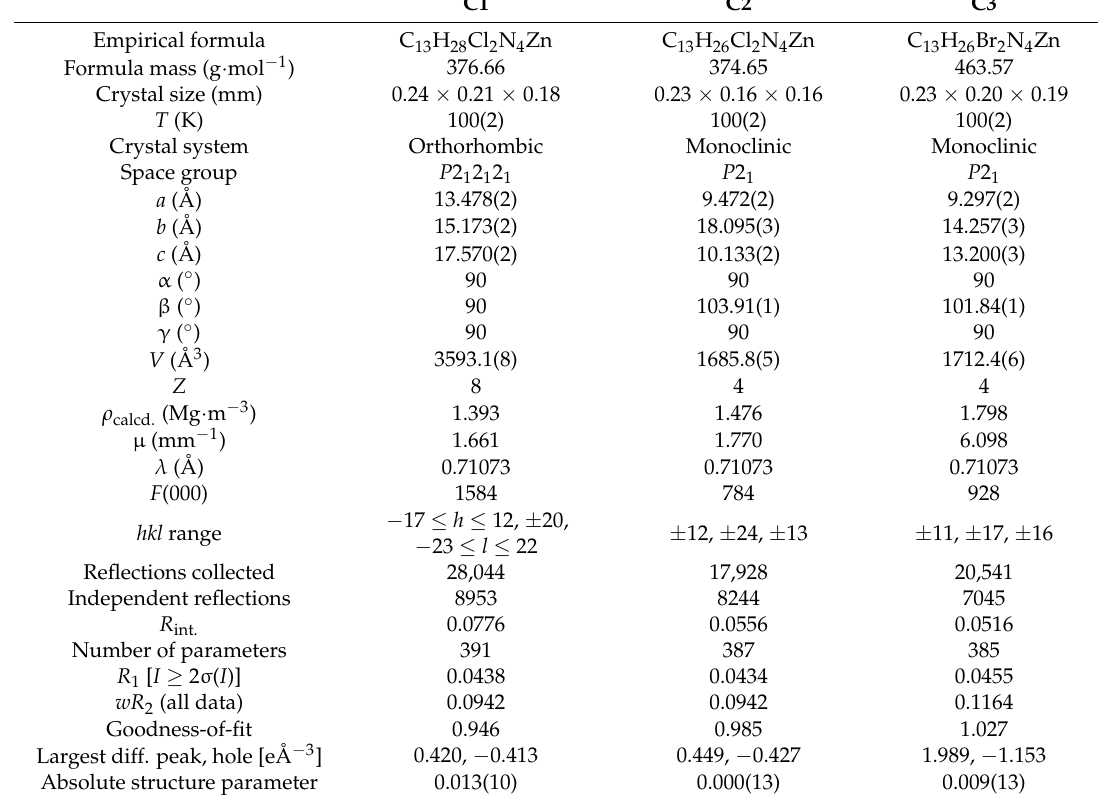
Table 7. Crystallographic data and parameters for C1 – C3